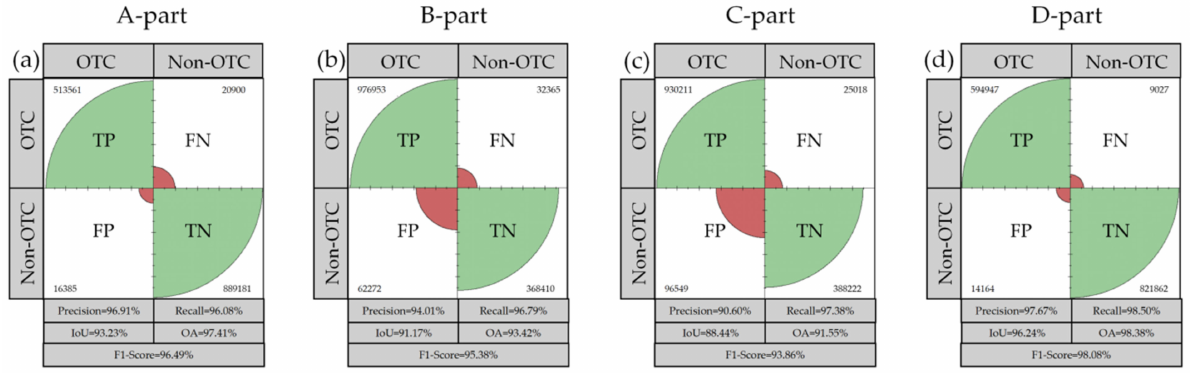
Figure 11. Extraction accuracy of olive tree crown number using the U 2 -Net model. ( a – d ) indicate the accuracy evaluation plots of four test subareas (A–D). In the figure, the green part indicates the proportion of pixels correctly classified as OTC and non-OTC, and the red part indicates the proportion of pixels incorrectly classified as OTC and non-OTC.